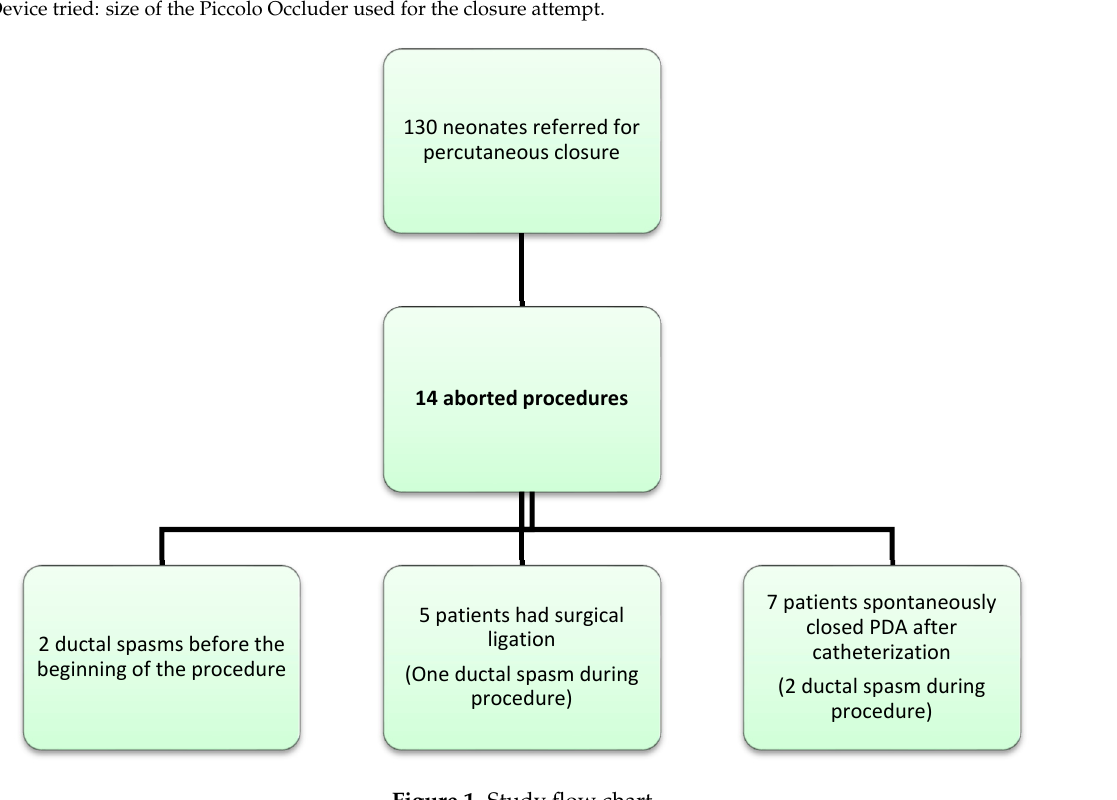
Figure 1. Study flow chart .